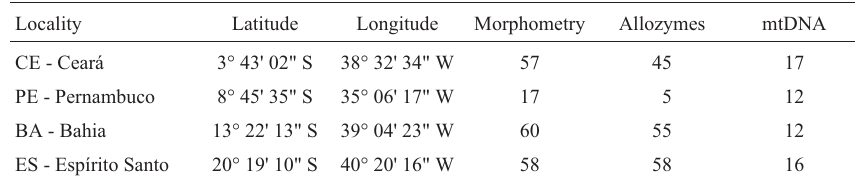
Table 1 - Sampling localities and number of specimens used for each analysis.